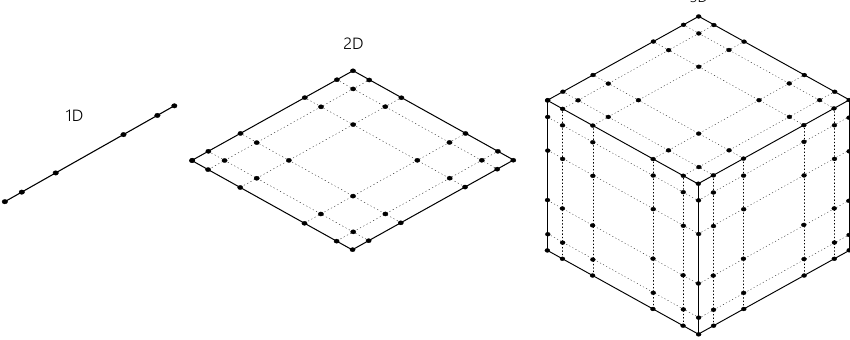
Figure 2. Exemplary node distribution in TDSFEM element